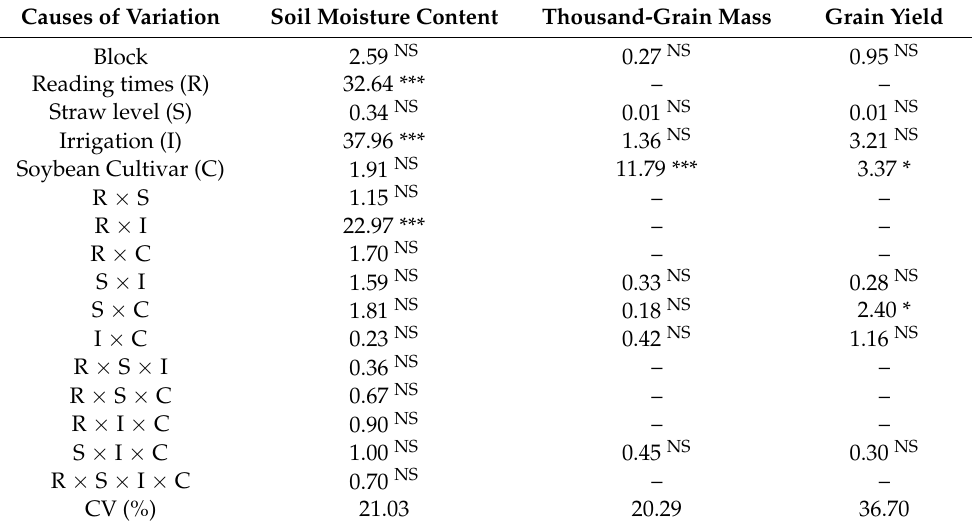
Table 3. Summary of analysis of variance for soil moisture content, thousand-grain mass, and soybean grain yield in response to soil moisture reading times, ruzigrass straw level on the soil surface, irrigation system management, and soybean cultivar. Causes of Variation Soil Moisture